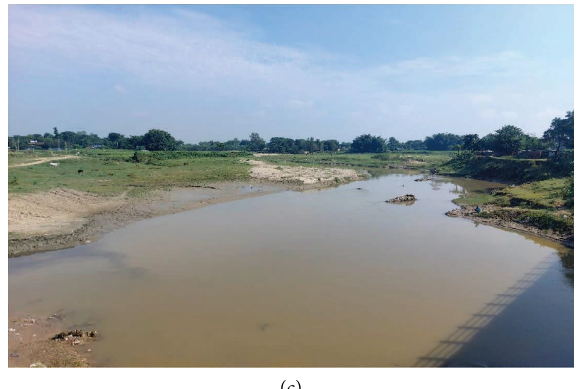
Figure 4: A. waikhomi recorded the habitat of the Singhiya River: (a) Singhiya bridge; (b) north to the Singhiya bridge; (c) south to the Singhiya